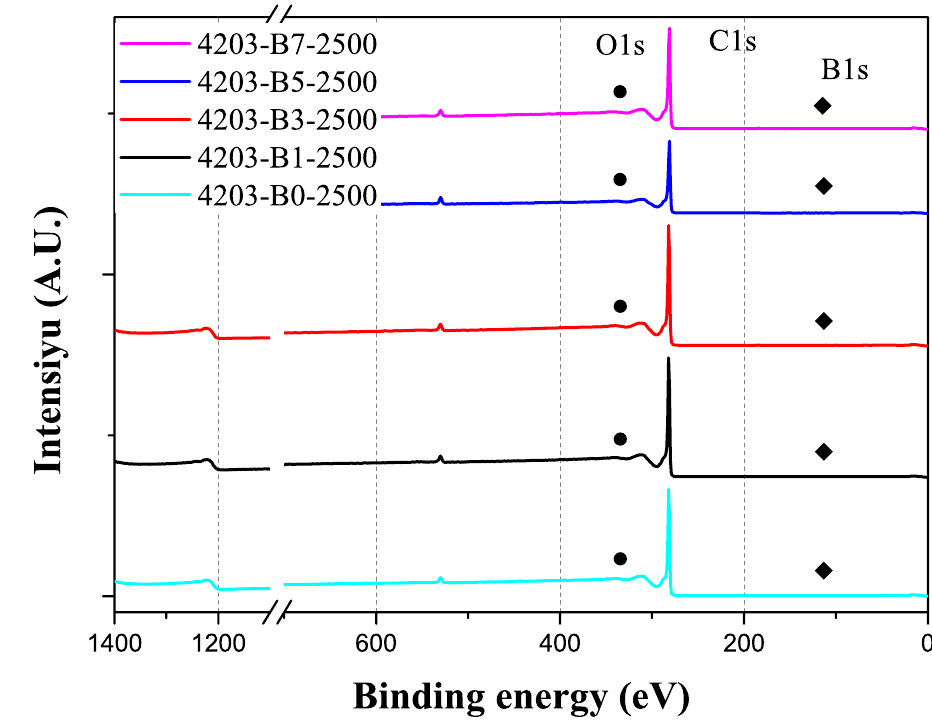
Fig. 6 XPS survey scan of 4203-BX-2500 and Fig. 7